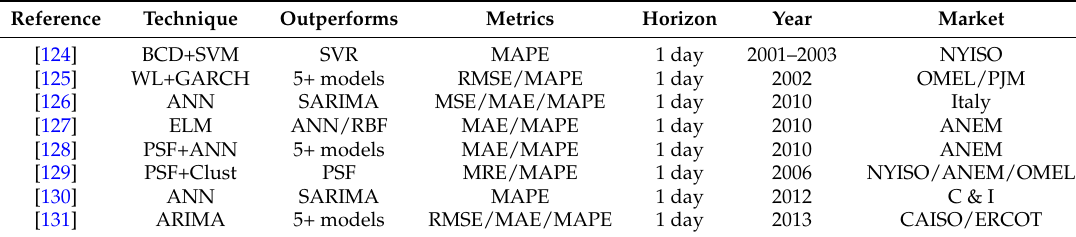
Table 9. Summary on ensembles for electricity